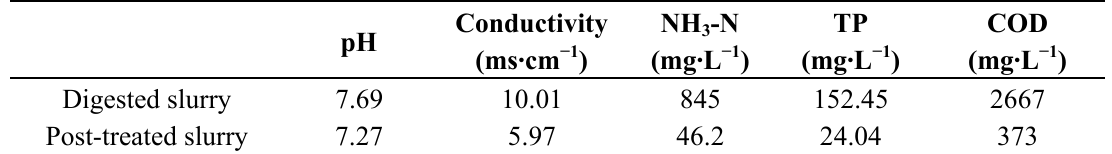
Table 1. Routine physicochemical index of test slurry.